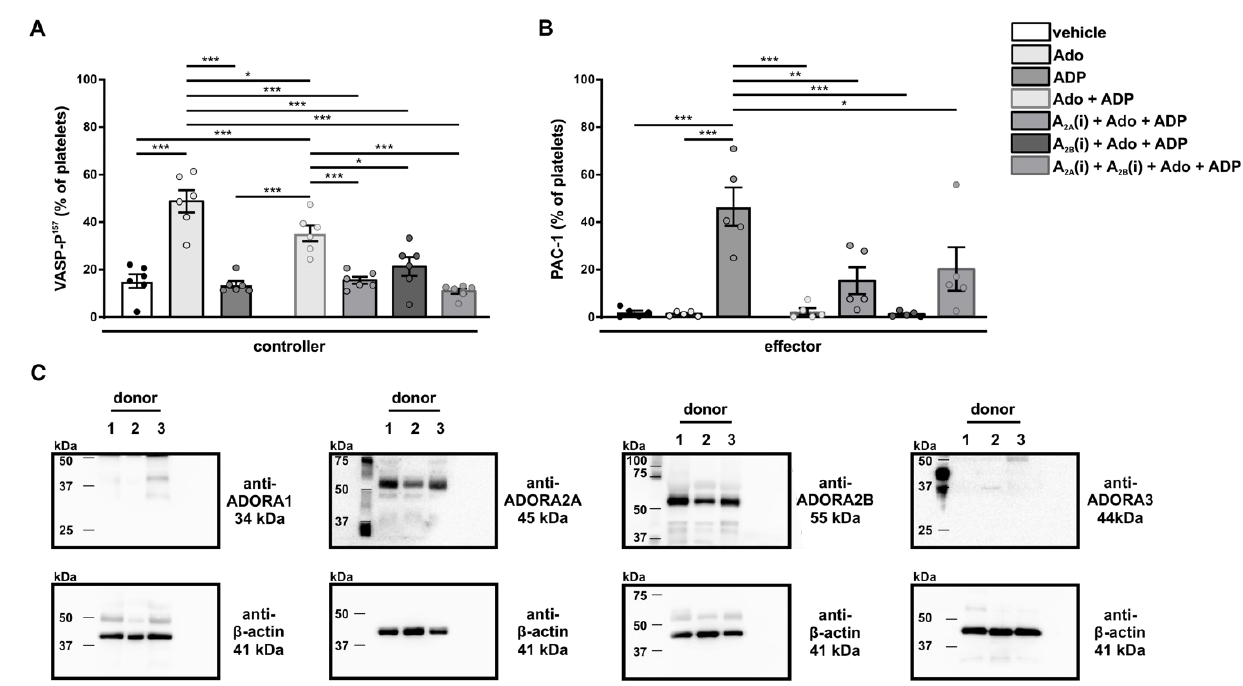
Figure 8. Analysis of the negative feedback loop. ( A ) Percentage of VASP-P 157 phosphorylation and ( B ) GPIIb/IIIa activity (PAC-1) in human platelets after treatment with 12.5 µ g/mL Ado and 5 µ M ADP and in the presence of ADORA 2A and ADORA 2B inhibitors (10 µ g/ µ L), as indicated. Additionally, stimulation of platelets with 10 µ M ADP is shown in Figure A3. n ≥ 3; one-way ANOVA with Tukey’s multiple comparisons test with * for p < 0.05; ** for p < 0.01; *** for p < 0.001. ( C ) Immunoblot analysis of ADORA subtypes in human platelets of three donors. One representative image for each ADORA receptor (upper panel) and the corresponding β -actin control (lower panel) out of three experiments is shown.